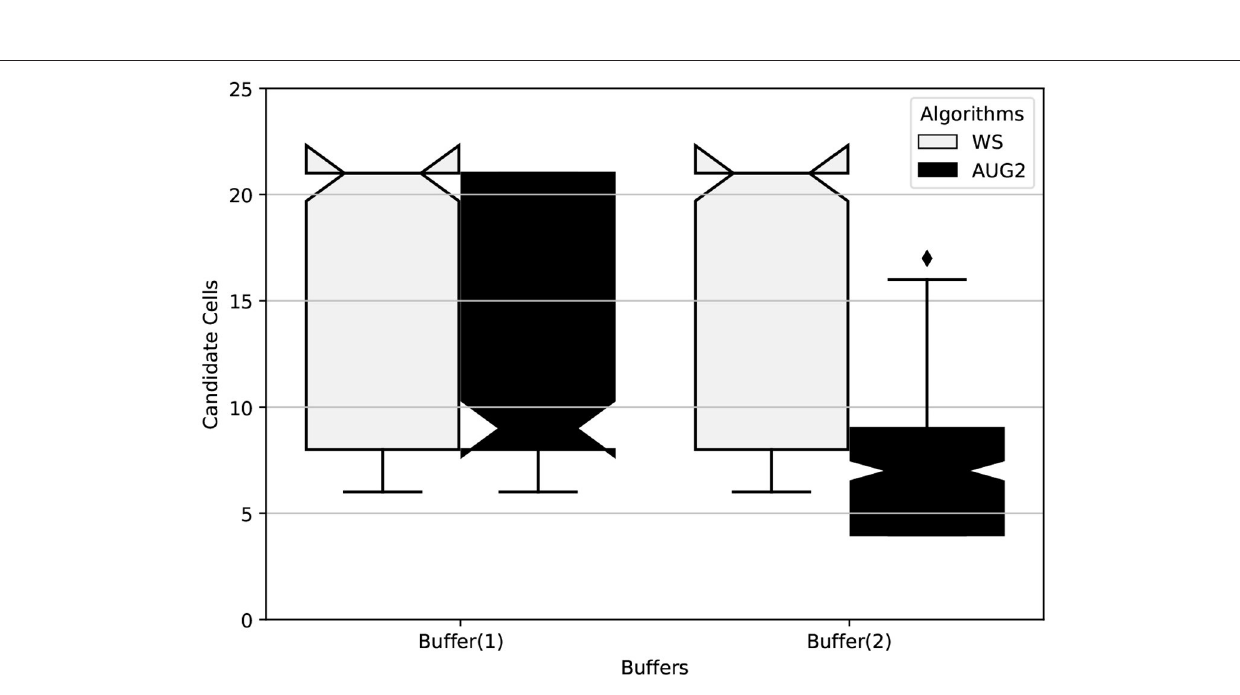
FIGURE 12 | The average candidate cells of all configurations for each